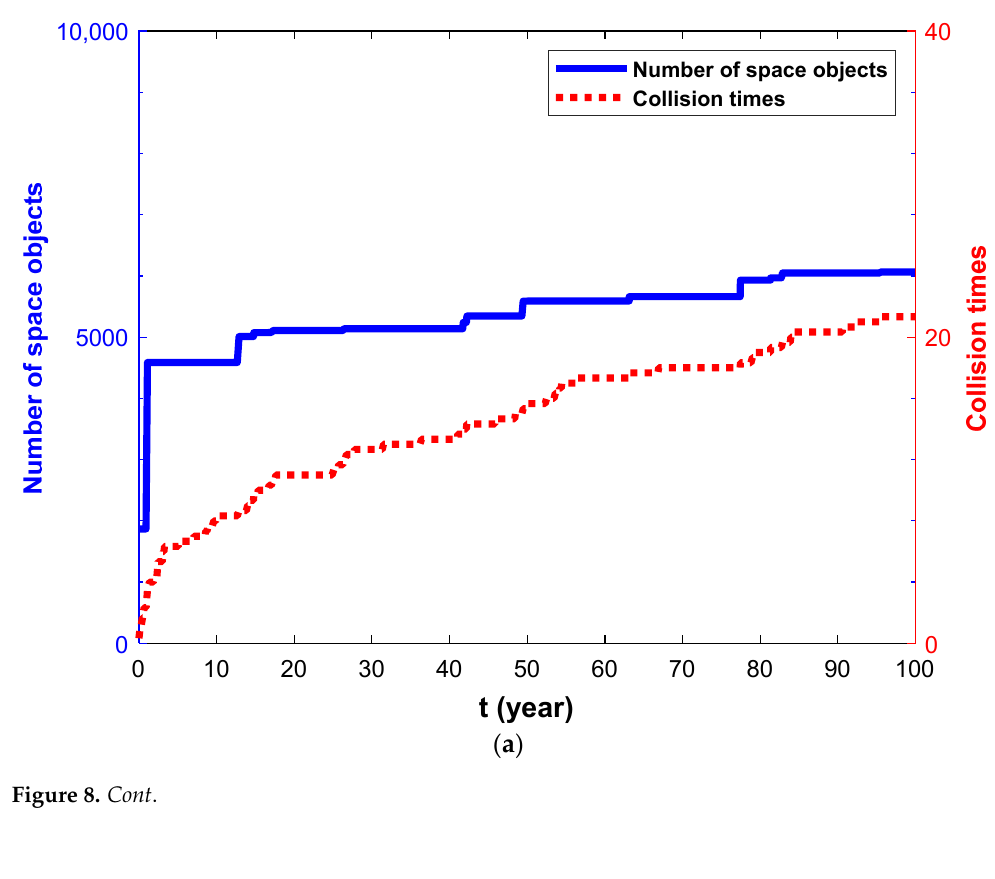
Figure 7. Twenty simulation experiments of scenario 4. The simulations with the largest and smallest numbers of space objects after 100 years in this scenario are shown as Figure 8. The red dotted lines represent the total number of collisions since the first collision at 0:00 on 1 February 2022, and the blue solid lines rep- resent the number of space objects larger than 0.05 m in the GEO band.